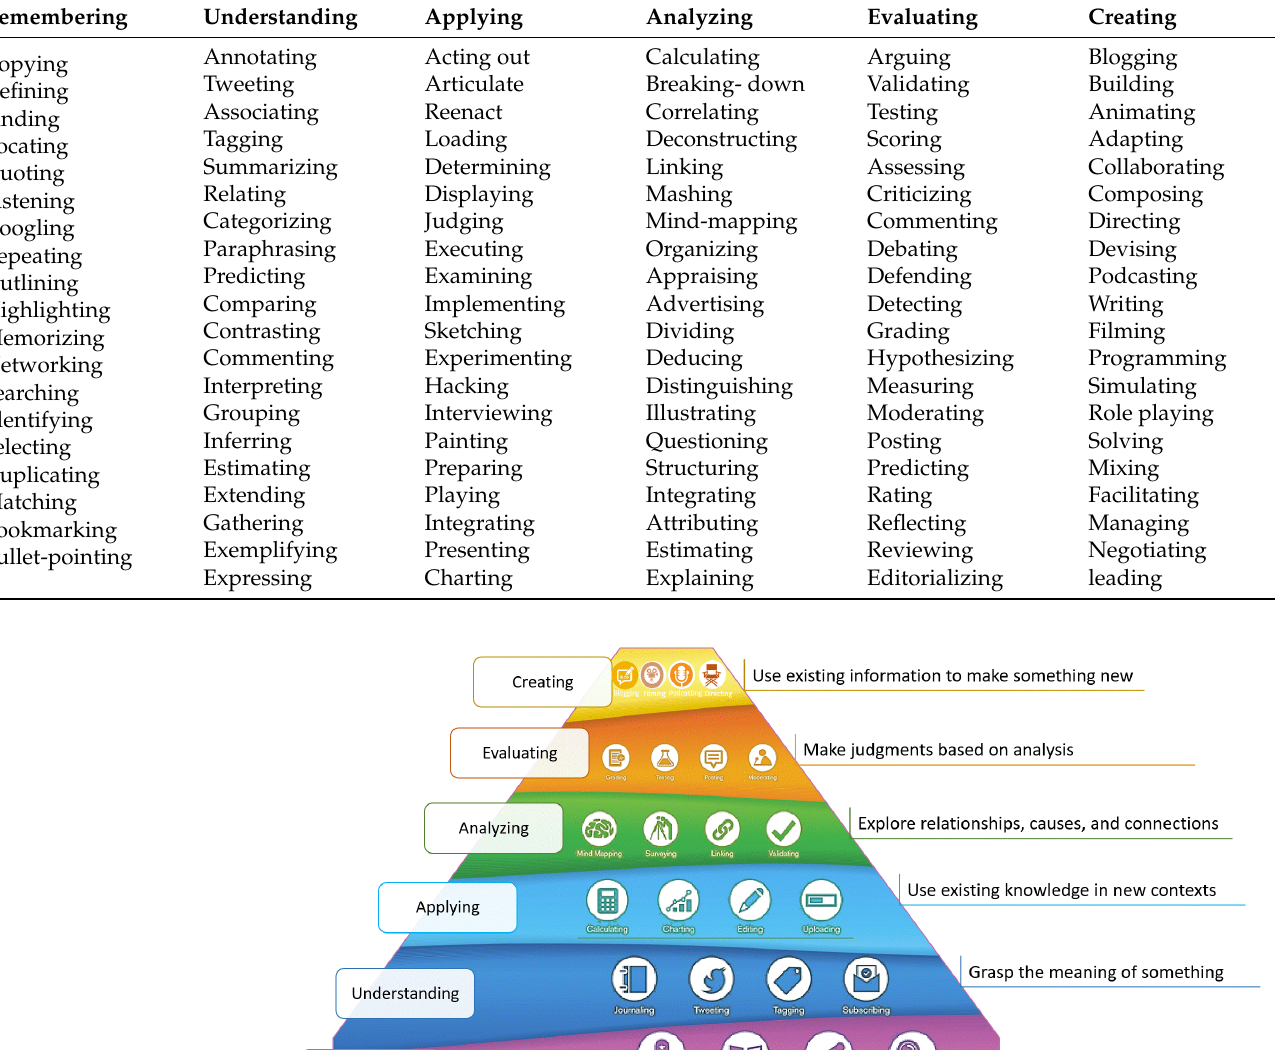
Table 2. Bloom’s Taxonomy Digital Planning Verbs [14].